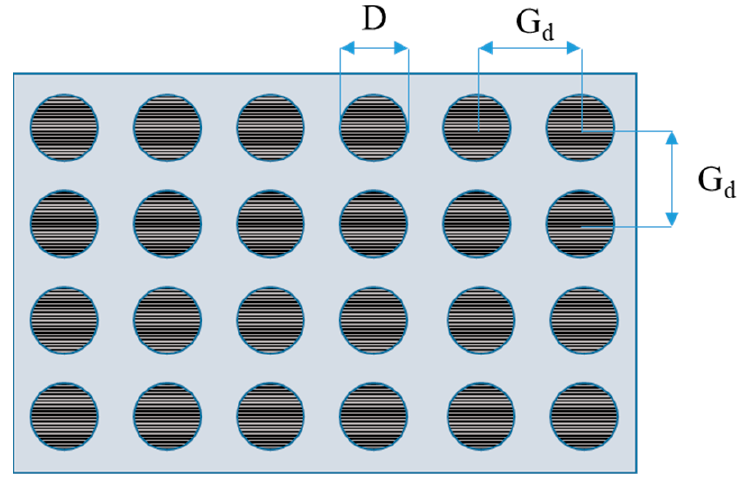
Figure 2. Texturing scheme adopted for the laser treatment: The texturing parameters were the dimples dimension ( D ) and the grid dimension ( G d ).